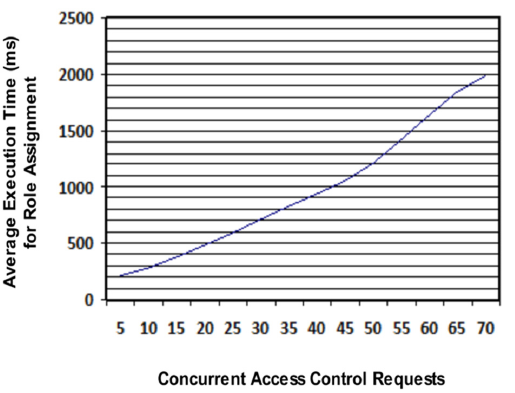
Figure 11. System response time in assigning roles for concurrent access control requests.